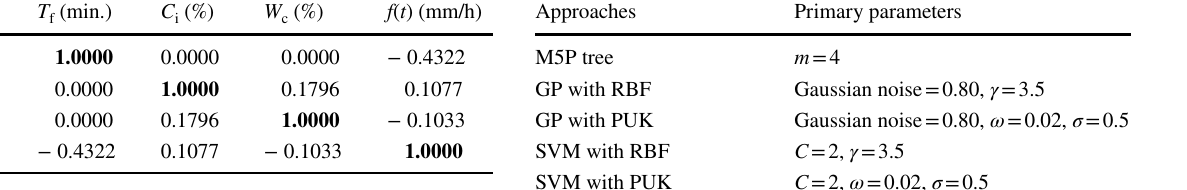
Table 4 Primary parameters using GP, SVM and M5P tree